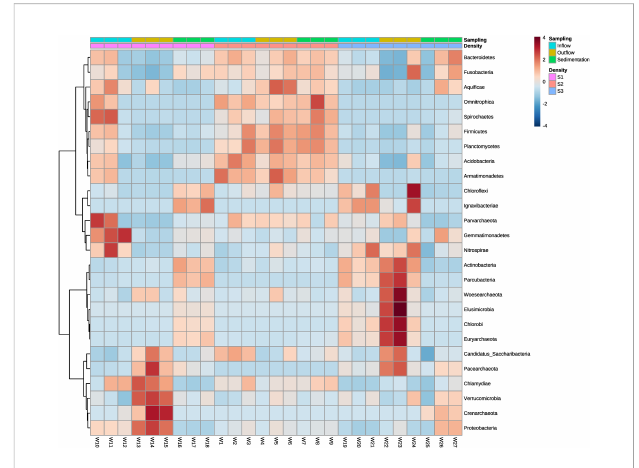
FIGURE 6 Heatmap showing the relative abundances of ASVs from water in fl ow, water out fl ow and sediment at intensive, semi-intensive and extensive systems. The taxonomy of ASVs (phyla) appears on the left. Differential abundances appear in two colors, red and blue, corresponding to low and high abundance of ASVs in the phyla respectively. High intensity colors denote in which sample the ASVs are more abundant. The legend on the right indicates the range of colors that represent each abundance (from -2 to 2) and the types of systems and samples. S1: high-density system; S2: medium-density system; S3: Low-density